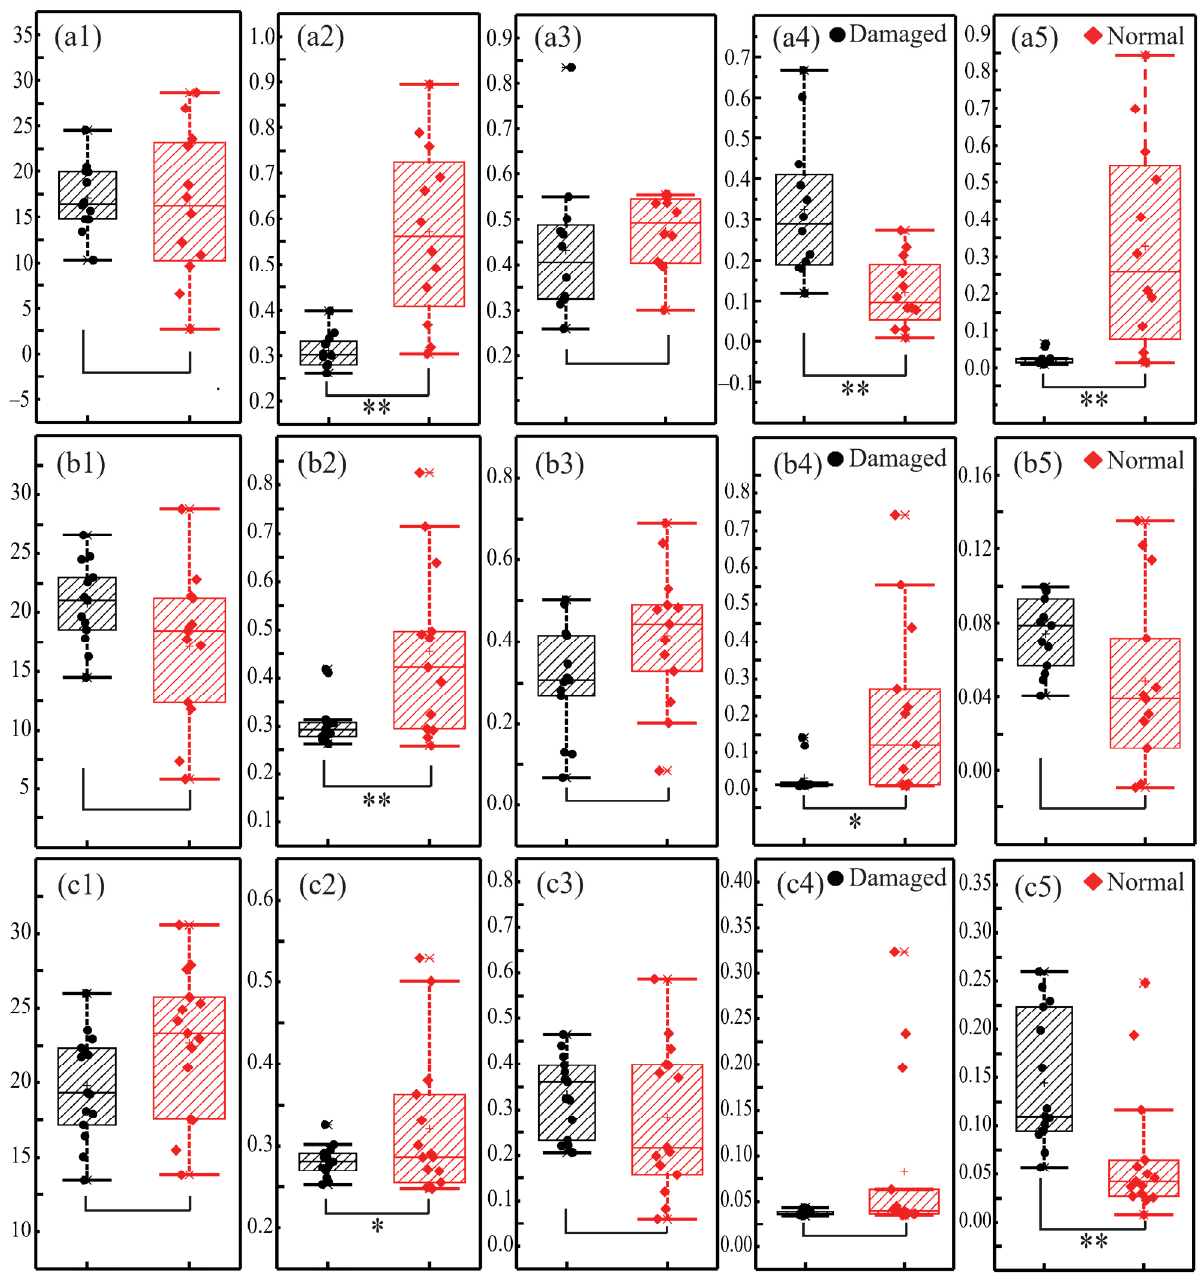
Figure 3. Quantitative damage assessment results of the damaged (black dots) and normal (red diamonds) regions: ( a1 – a5 ) distributions of the parameters contrast, homogeneity, correlation, energy, and mean for the stratum corneum layer; ( b1 – b5 ) distributions of the parameters contrast, homogeneity, correlation, energy, and mean for the epidermis layer; and ( c1 – c5 ) distributions of the parameters contrast, homogeneity, correlation, energy, and mean for the dermis layer. No “*” symbol means p > 0.5, or not significant; “*” means p < 0.05, or significant; “**” means p < 0.01, or very significant.